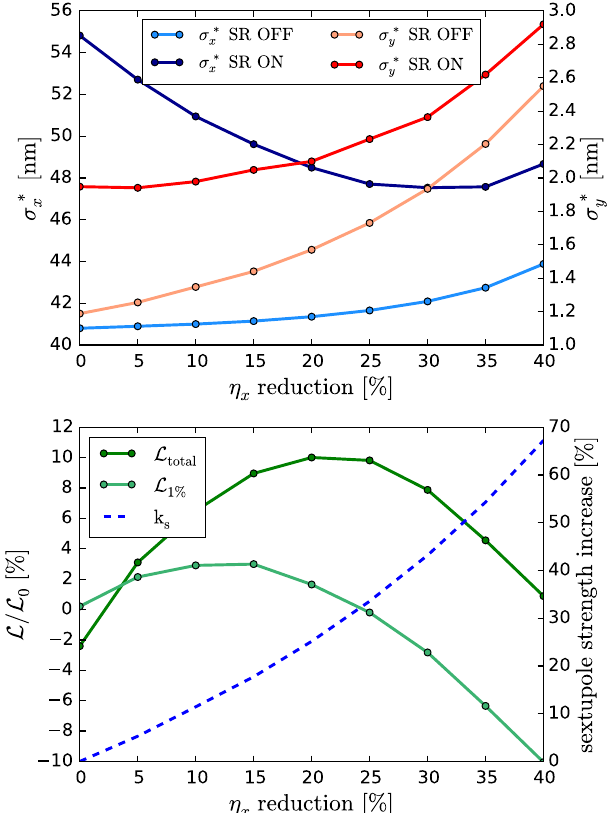
FIG. 6. Impact of the dispersion level in the FFS on the horizontal and vertical beam sizes σ (cid:1) x;y (top plot), luminosity, and sextupole strength k 2 (bottom plot) when η x is reduced up to 40%.